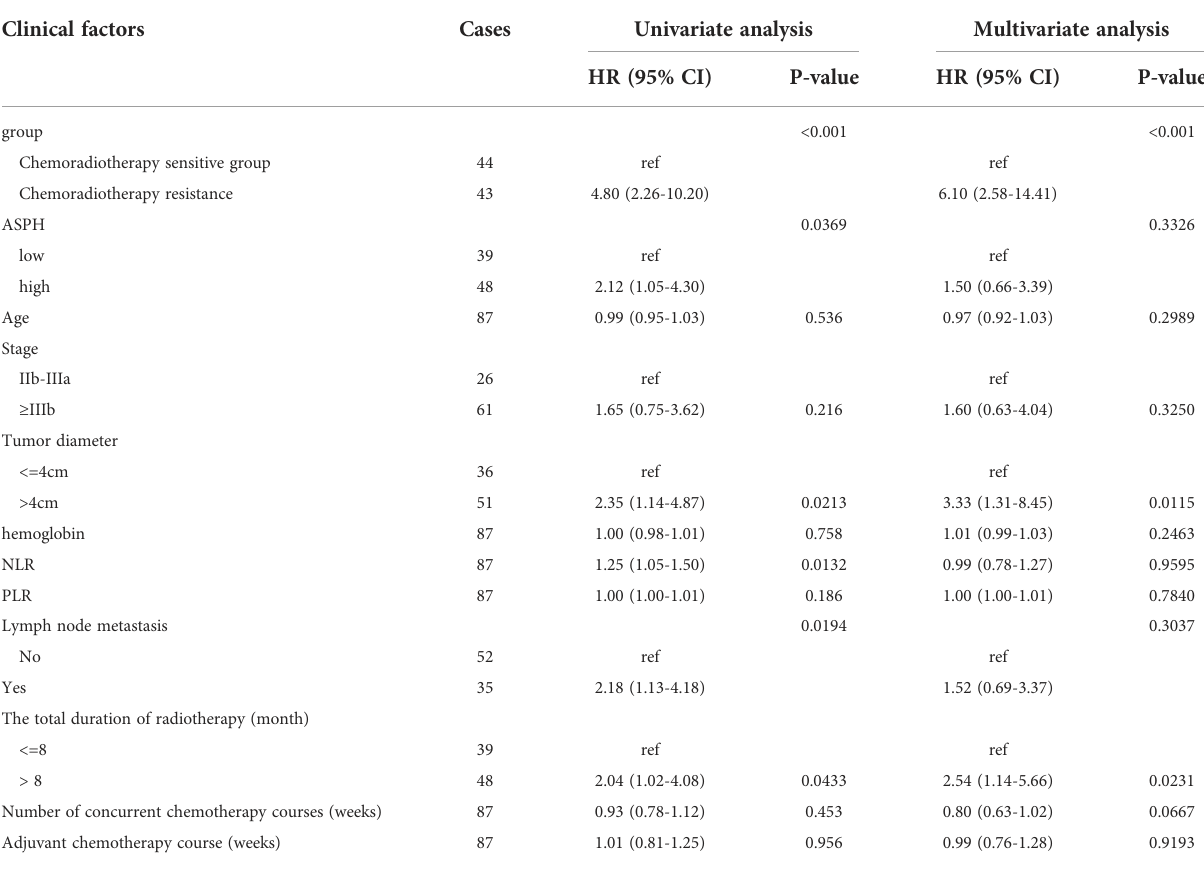
TABLE 5 Analysis of clinical factors affecting PFS of radiotherapy and chemotherapy in intermediate and advanced cervical squamous cell carcinoma. Clinical